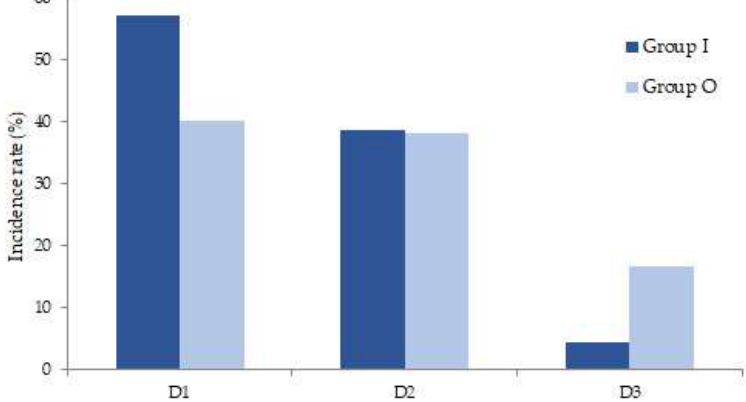
Figure 3. Duration of adverse events. D1, 2 h; D2, 2–12 h; D3, 24 h.